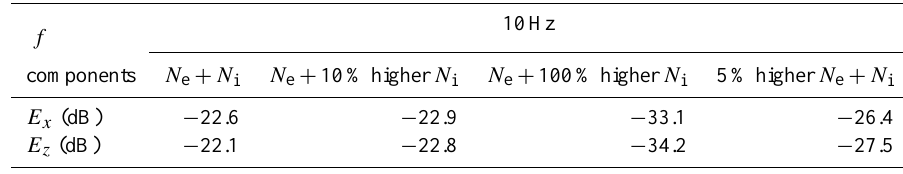
Table 2. Simulation results of E x and E z (660km altitude) with different N e and N i profile at 10Hz.